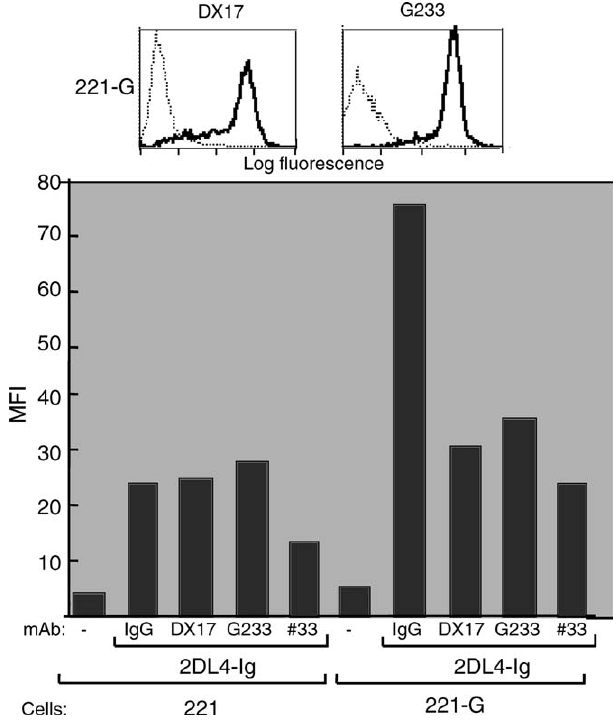
Figure 7. Binding of KIR2DL4-Ig Fusion Proteins to HLA-G–Expressing Cells Is Blocked by Anti-KIR2DL4 and Anti-HLA Class I mAbs (Top) 221-G cells were stained with mAb DX17 (pan–HLA class I mAb) and mAb G233 (HLA-G–specific mAb) (solid lines). Staining with secondary antibody alone is also shown (dotted lines). (Bottom) The 221 and 221-G cells were incubated with 50 l g/ml KIR2DL4-Ig fusion protein in the presence of 20 l g/ml of either isotype- matched control Abs or mAbs specific for class I (DX17), HLA-G (G233), or KIR2DL4 (33). Cells were then stained with goat anti-human IgG1 secondary antibodies and assessed by flow cytometry. The data are expressed as mean fluorescence intensity (MFI). DOI: 10.1371/journal.pbio.0040009.g007